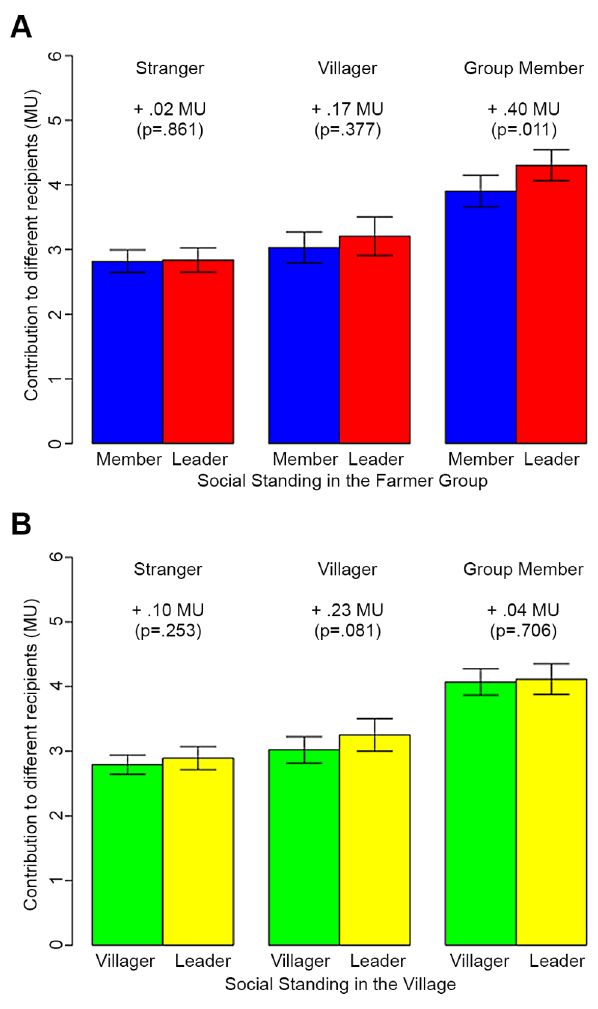
Figure 3. Holding a formal position increases prosocial behavior toward in-group members. Farmer group leaders allocated to members, on average, 0.40 s MU more than regular farmer-group members ( p ~ : 011 ). Leaders in the village gave, on average, 0.23 MUs more to co-villagers than regular villagers ( p ~ : 081 ). The contribution of both types of leaders did not differ from average group members when receivers were either strangers or members of a group in which they did not hold formal leadership positions. Predicted average contributions derived from multilevel regressions in which we model the contribution to strangers, villagers and farmer group members, controlling for individual and group level character- istics. Whiskers indicate the 95% interval, while the difference between regular members/villagers and leaders and its significance is reported in the graph. See SI Appendix, Table 1 for results in tabular